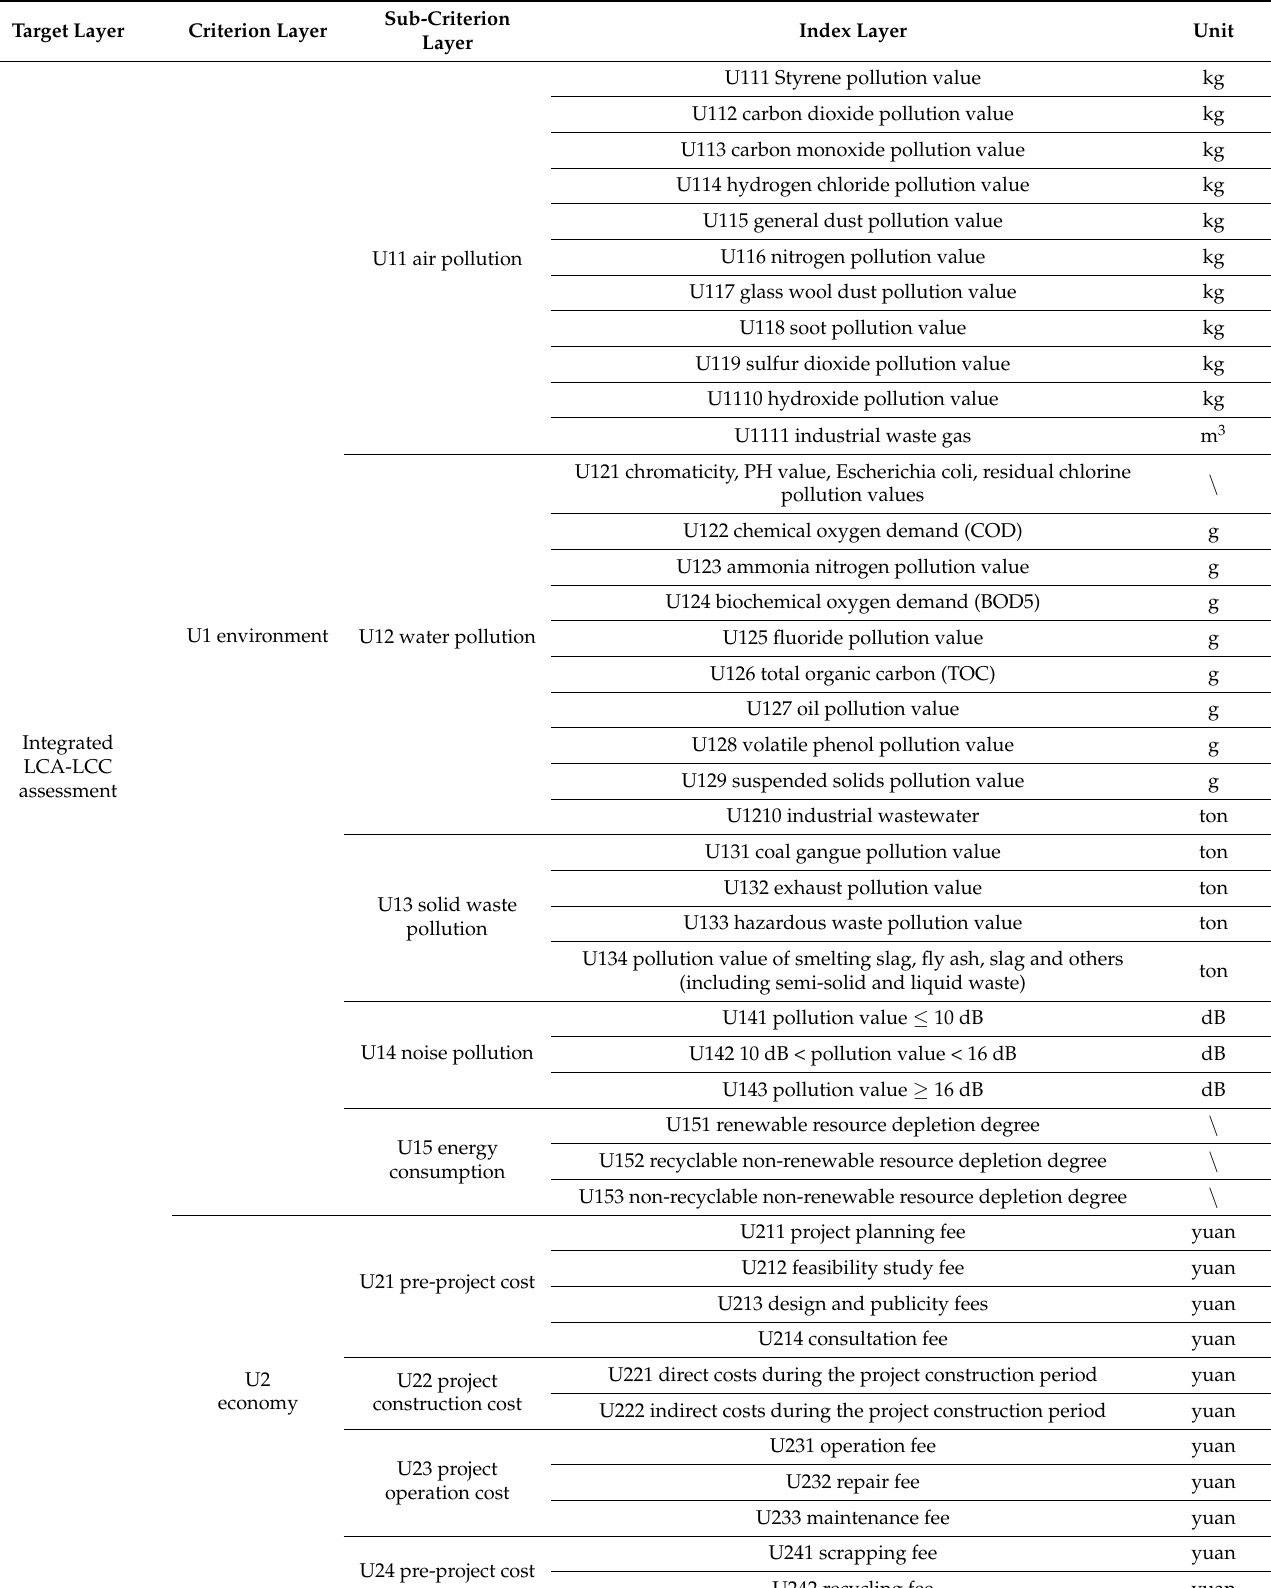
Table 1. LCA-LCC integration assessment index